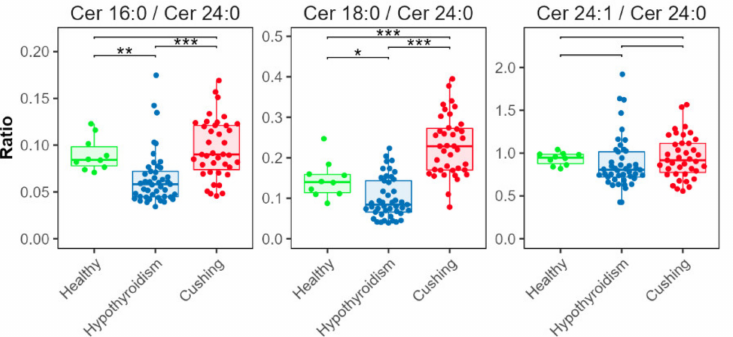
Figure 7. Ceramide ratios. Concentration ratios of Cer d18:1/16:0 (indicated as Cer 16:0), Cer d18:1/18:0 (Cer 18:0), and Cer d18:1/24:1 (Cer 24:1) with Cer d18:1/24:0 (Cer 24:0). Levels of statistical significance between two groups calculated by two-tailed Welch’s t -tests are indicated with stars: * p ≤ 0.05, ** p ≤ 0.01, *** p ≤